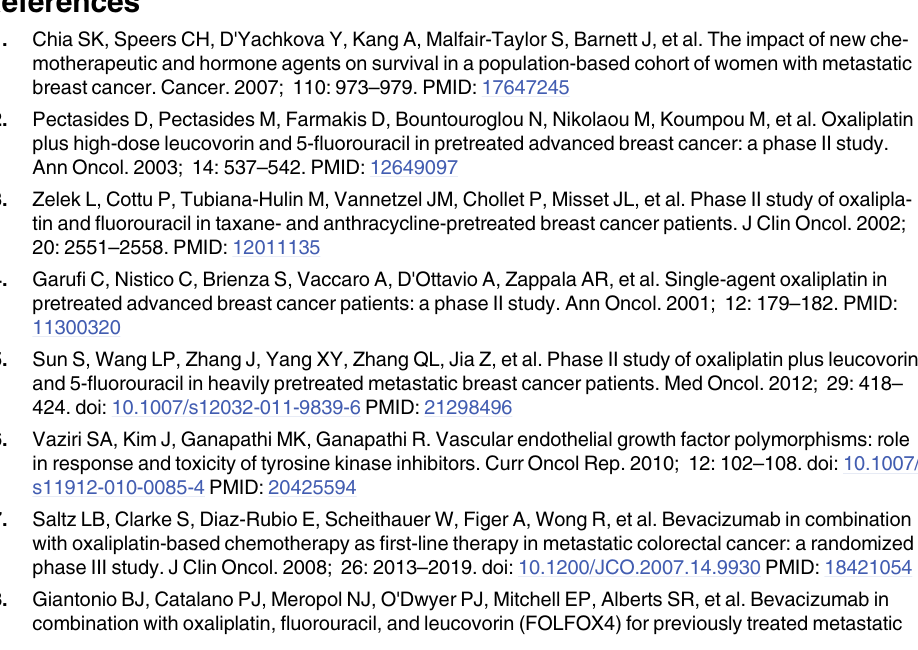
S1 Table. Clinical variables in univariate analysis. S2 Table. Clinical variables in multivariable analysis. S3 Table. Prior studies of chemotherapy regimens as second- or beyond line for MBC. S4 Table. Adverse events of present trial compared with those of our historical mFOLFOX6 trial. S5 Table. AEs of present trial in breast cancer compared with AEs in colorectal